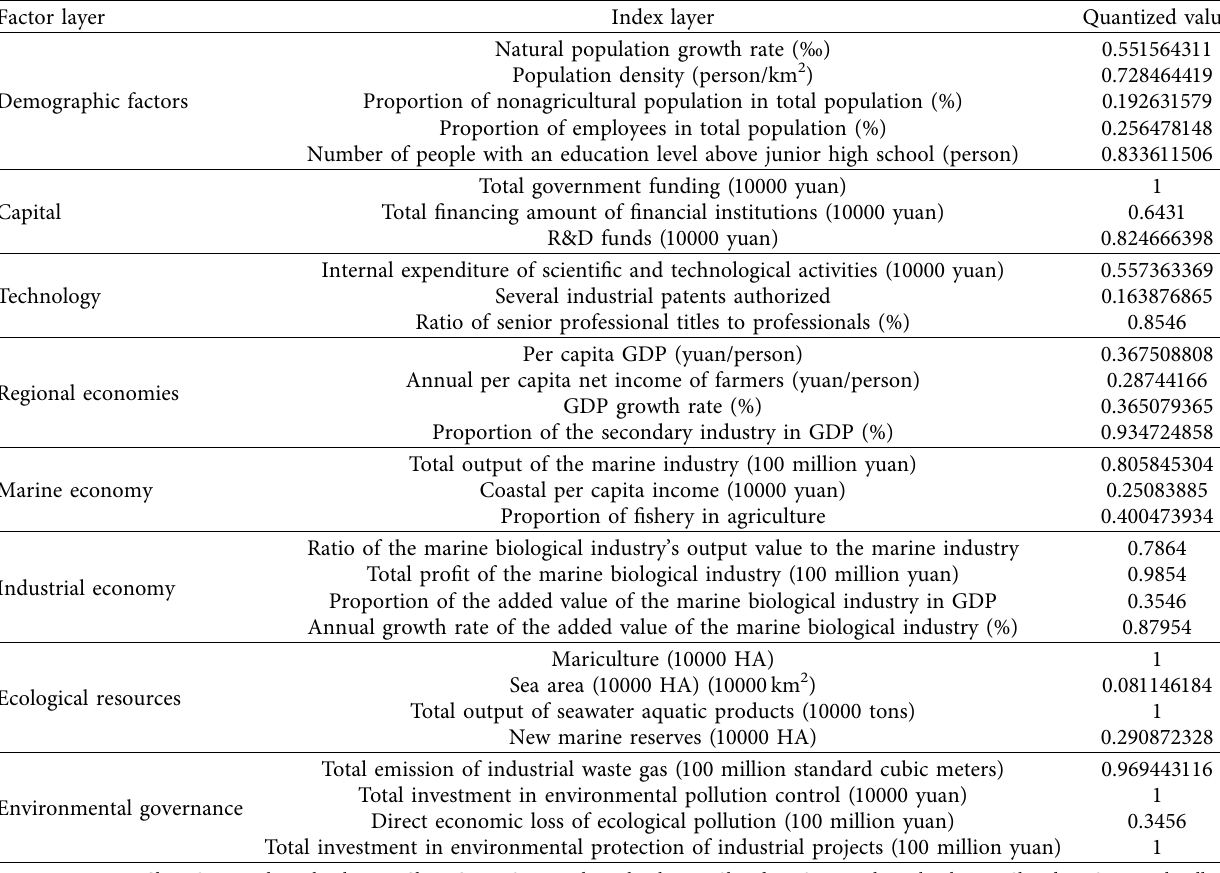
Table 2: Data processing table of the marine biological industry in Shandong